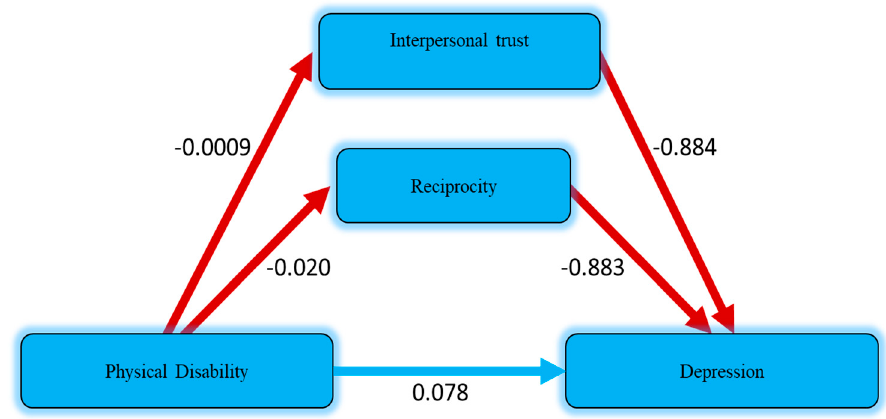
Figure 2. Estimated mediation effect of cognitive social capital on physical disability and depression.